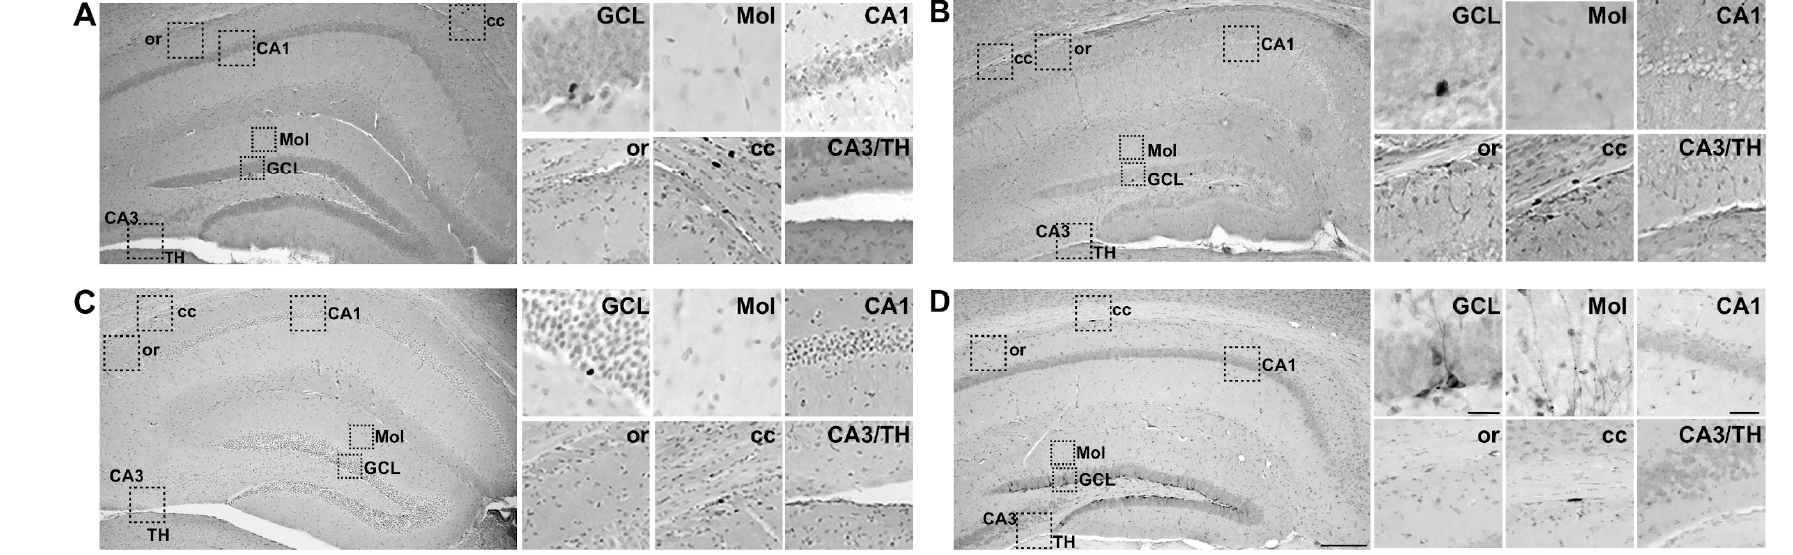
Figure 2. Representative photomicrographs of cells immunoreactive for neurogenesis markers (Ki67, BrdU, and DCX) in the hippocampus. ( A ) Large panel shows Ki67 immunoreactivity in a Sham mouse brain (mouse #14086) at low magnification (100 × ) collected 24 h post-sham treatment. Regions outlined in large panel (GCL, Mol, CA1, or, cc, CA3/TH) are shown at higher magnification in smaller panels to the right. Ki67+ cells are evident in the Granule Cell Layer (GCL) and corpus callosum (cc), but not in any other visible brain region. ( B ) Large panel shows BrdU immunoreactivity in a Sham mouse brain (mouse #14086) at low magnification (100x) collected 2 h after BrdU injection and 24 h post-sham treatment. Regions outlined in large panel are shown at higher magnification in smaller panels to the right.